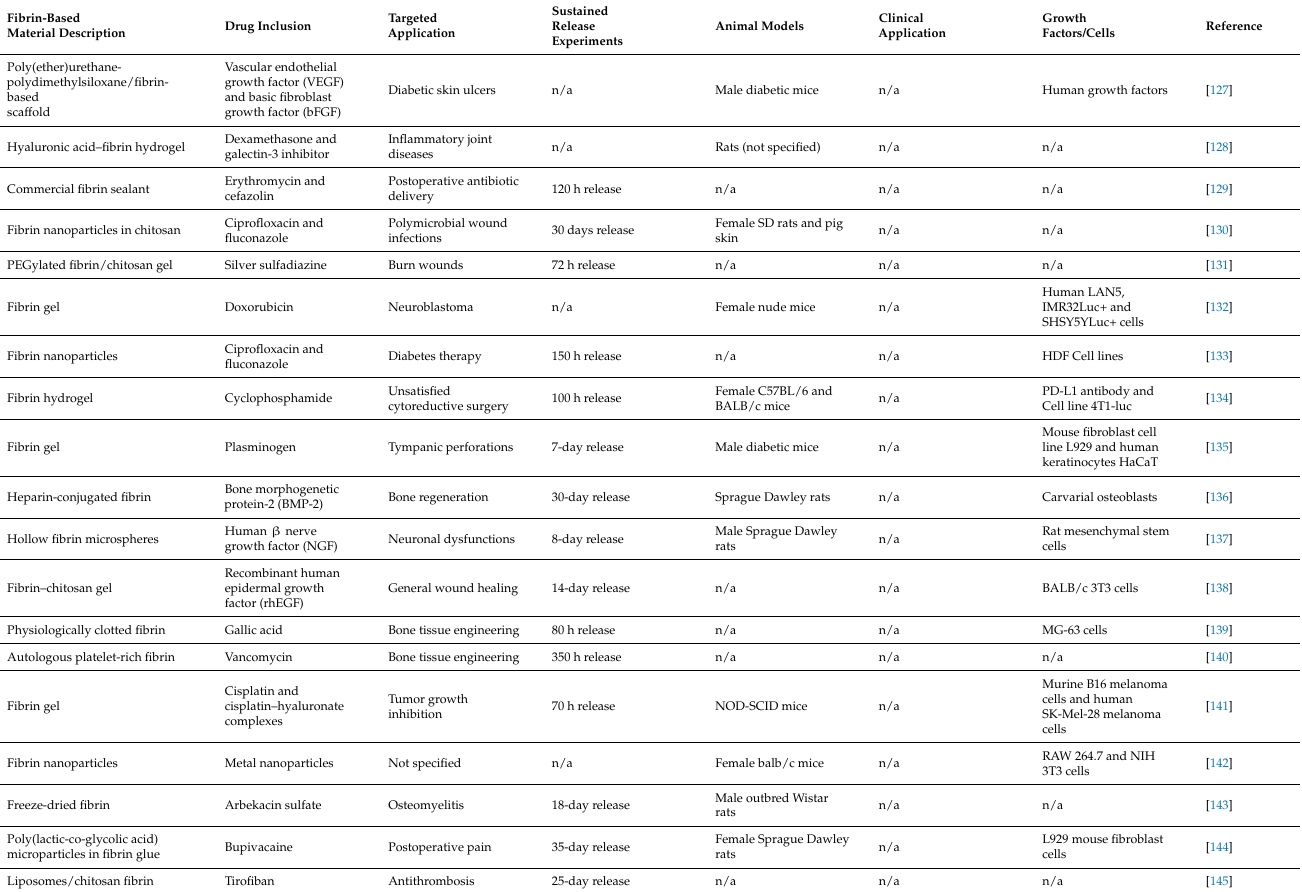
Table 2. Drug encapsulating and sustained release systems based on fibrin and fibrin composite wound repair